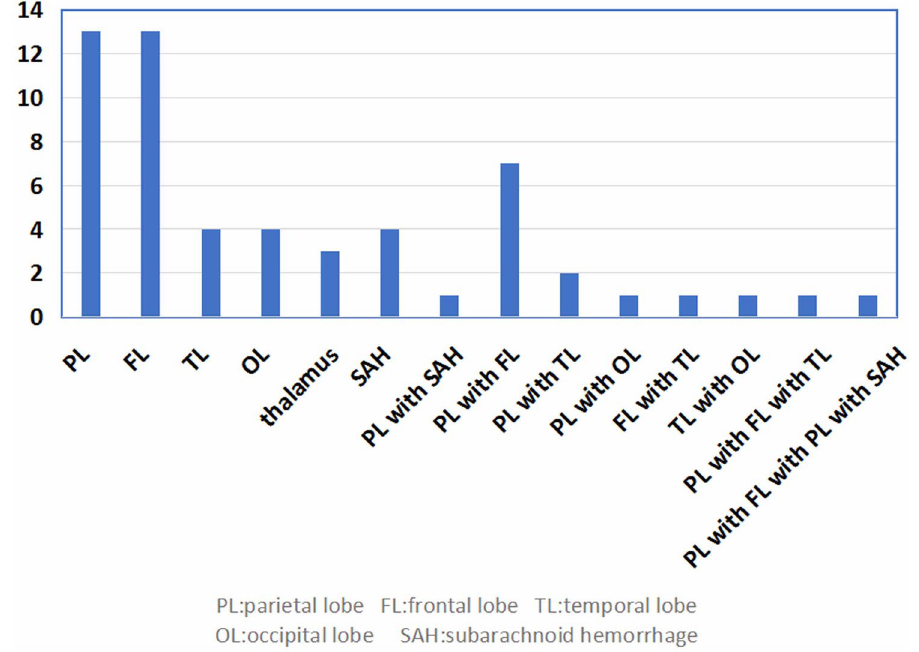
Figure 1. Localization and number of hemorrhage in 56 cases with CVST.